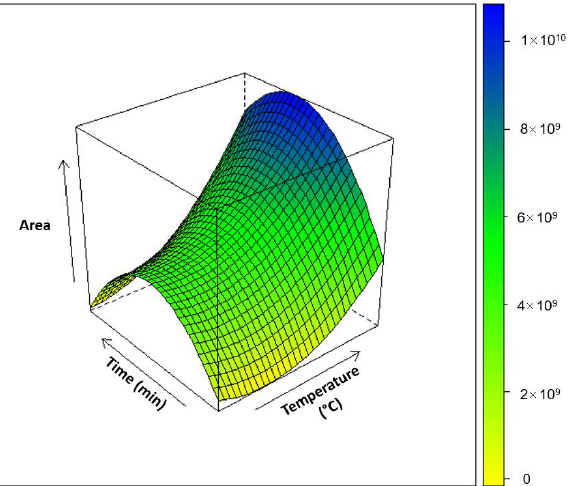
Figure 1. Response surface plot for the total sum of peaks areas of the standard mixture used as model for the HS-SPME optimization according to the DoE face-centred composite design (95% of the explained variance).